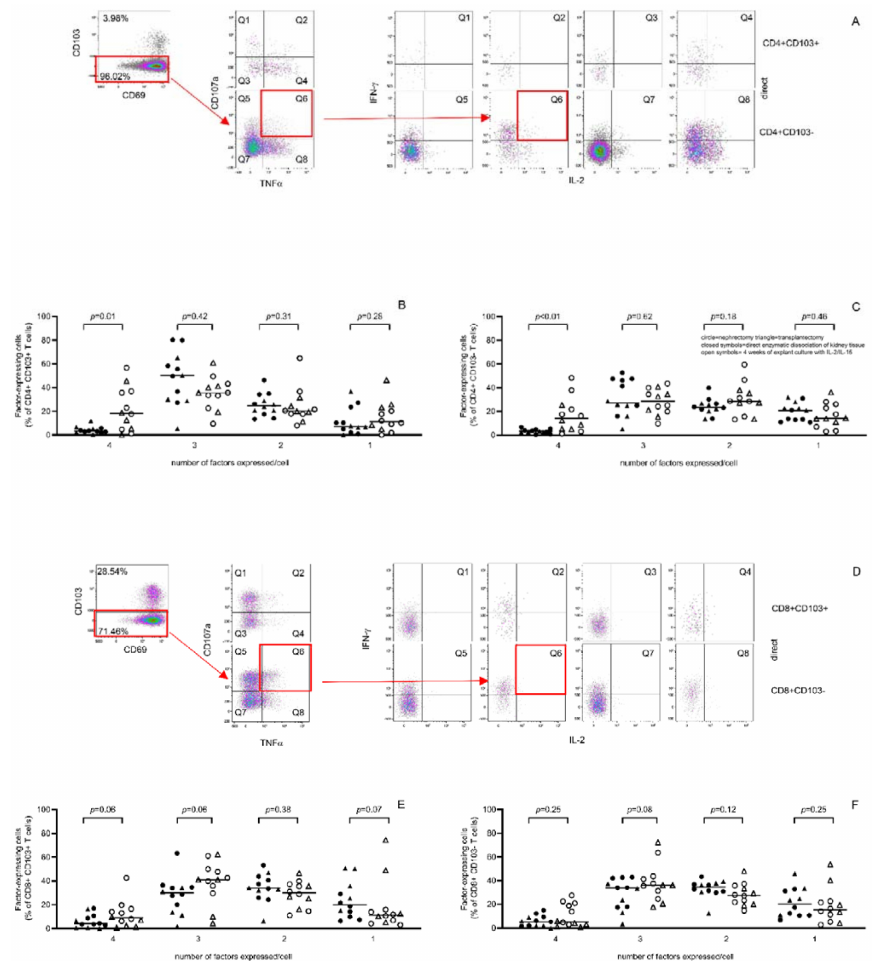
Figure 5. Poly-functional nature of T cells was maintained upon four weeks of explant culture in the presence of exogenous IL-2 and IL-15. A typical example of the flow cytometric gating strategy to evaluate the poly-functional nature of T cells is given in ( A ) (CD4+ T cells) and ( D ) (CD8+ T cells). For example, CD103 − T cells, highlighted by a red rectangle, are depicted in a dotplot with TNF- α on the x -axis and CD107a on the y -axis, cells positive for both (second red rectangle, Q6) are depicted in a dotplot, depicting IL-2 on the x -axis and IFN- γ on the y -axis and cells positive for both here represent cells expressing all factors examined (third red rectangle). The poly-functional